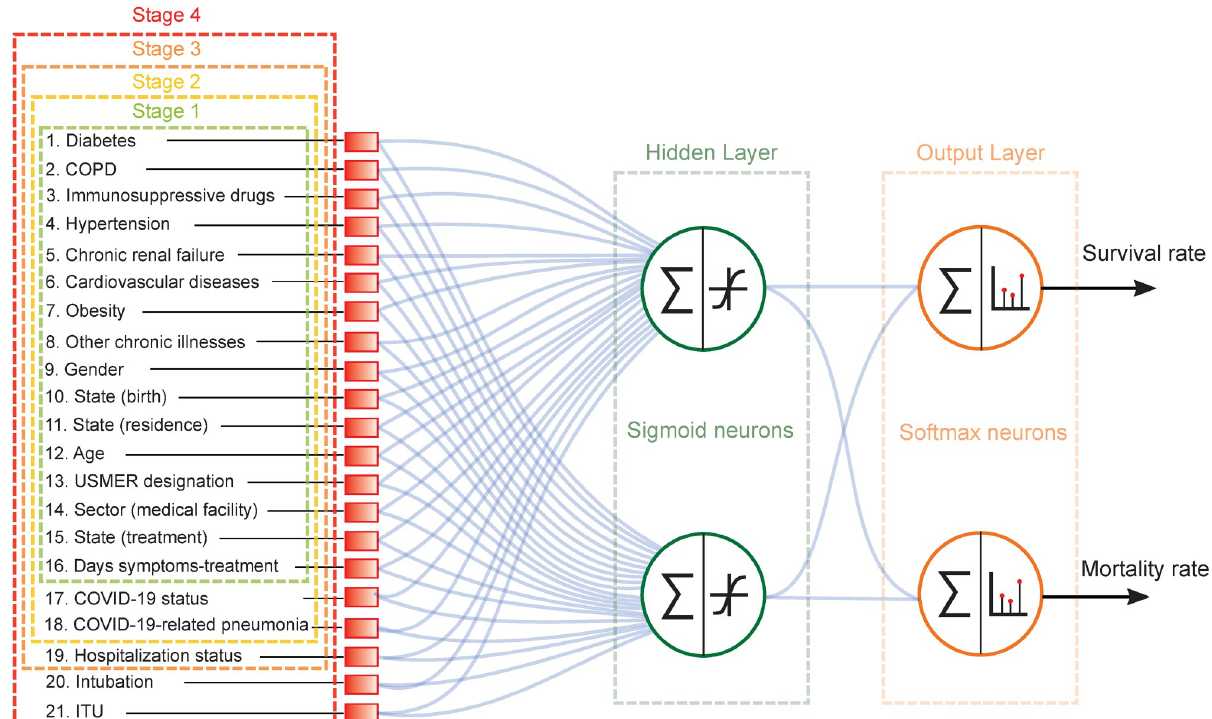
Fig 2. Architecture of the multilayer feed-forward neural network employed in order to classify patients into class 1 (recovered) and class 2 (deceased).